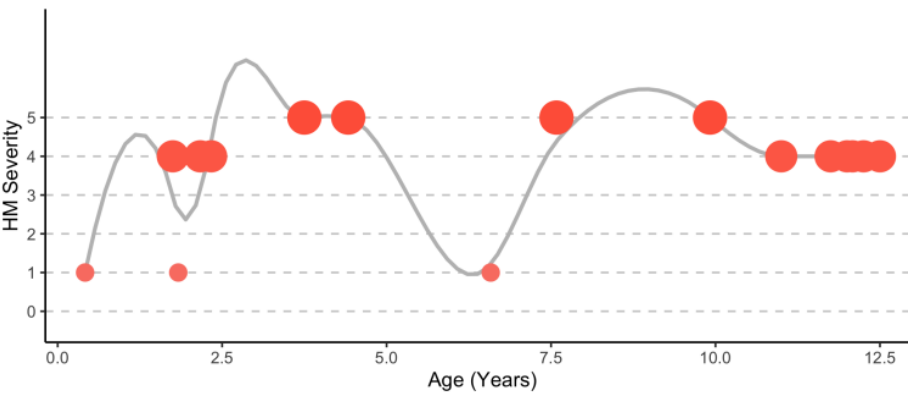
Figure 1. Graphic description of the natural history of the